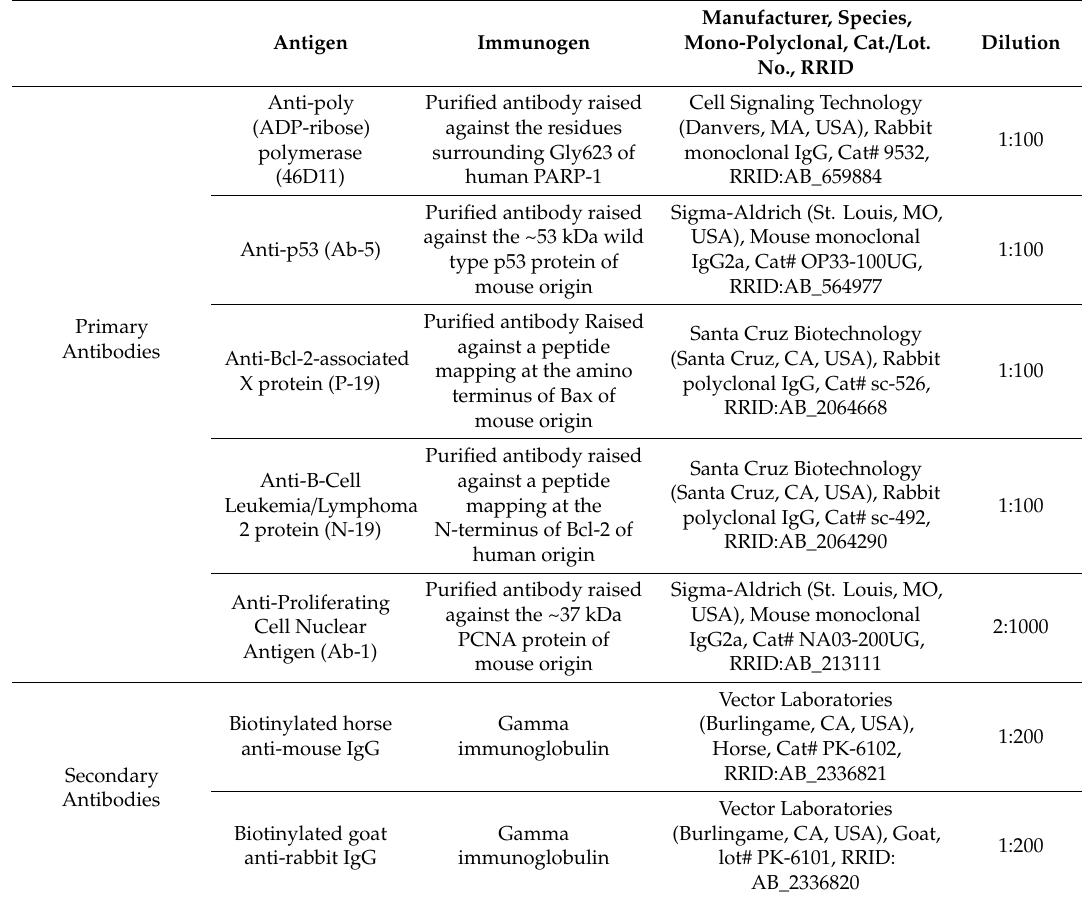
Table 2. Primary / secondary antibodies and respective dilution used for immunohistochemical experimental